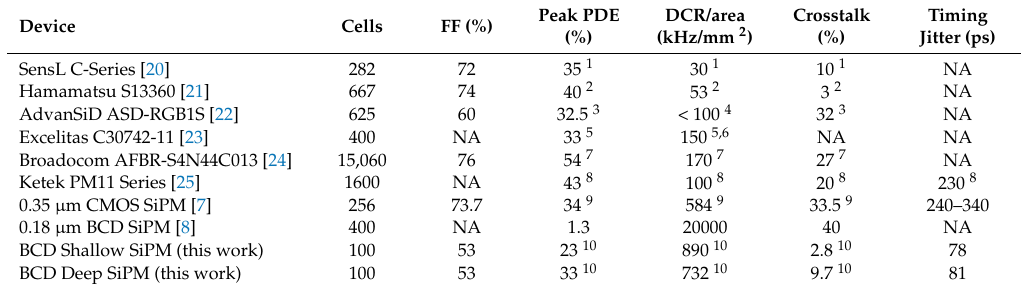
Peak PDE DCR/area Crosstalk (%) (kHz/mm 2 ) (%)